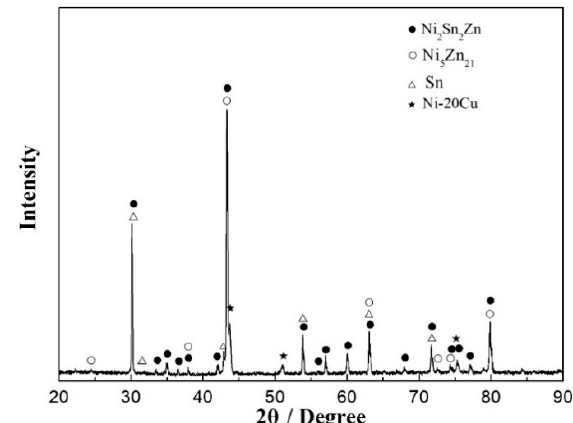
Figure 3. The X-ray diffraction (XRD) pattern of etched interface of Sn-Zn/Ni-20Cu joint after soldered at 250 °C for 16 h.